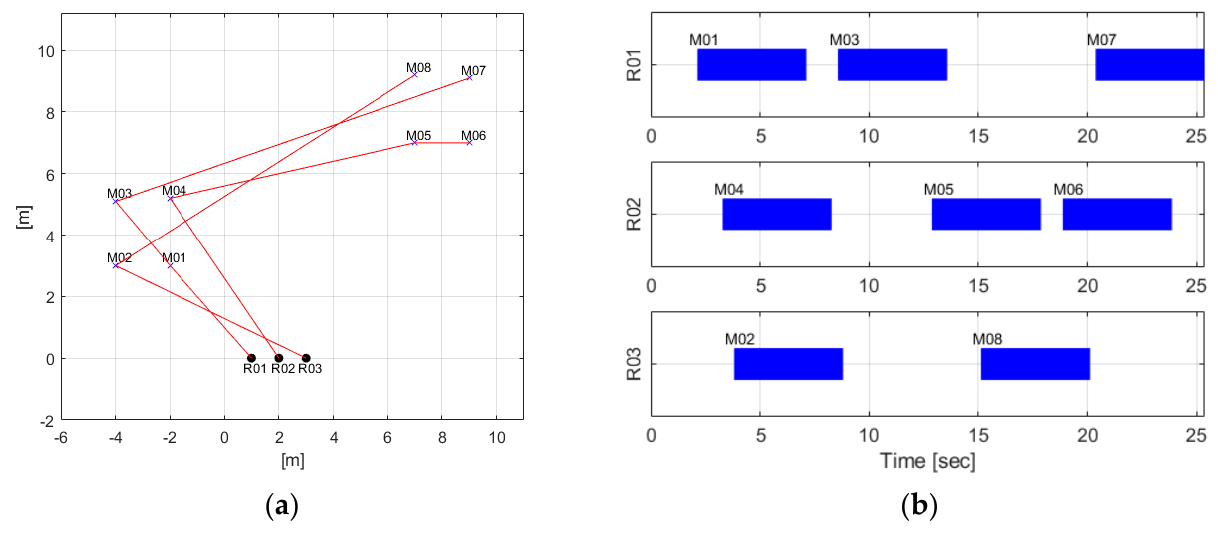
Figure 1. The results for simple case using CBBA: ( a ) 2D situation map; ( b ) timetable.